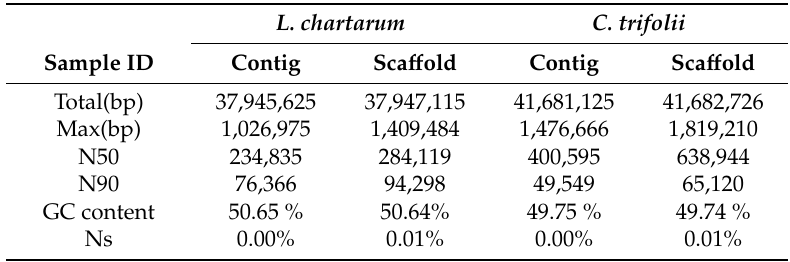
Table 1. Statistics of the final assembly of L. chartarum and C. trifolii genome. L. chartarum C.